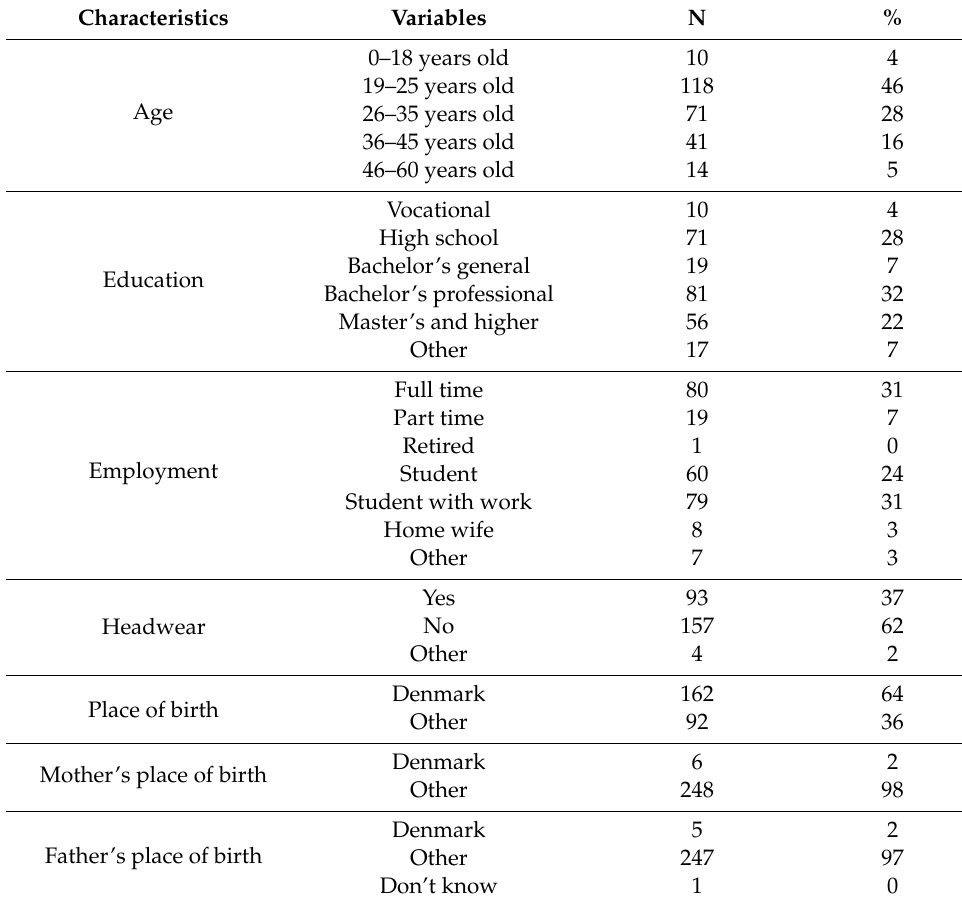
Table 1. Sociodemographic characteristics of the respondents.